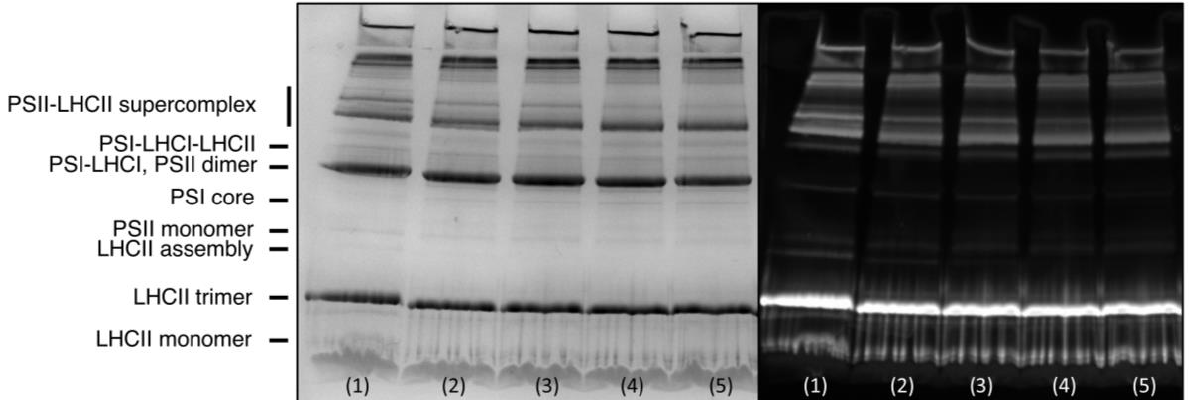
Figure 5. CN-PAGE of untreated isolated thylakoid membranes (lane 1) and membranes treated with 2 U mL − 1 PLA1 (lanes 2–5). The figure also shows the assignments of the different bands. Lanes 2–5 respectively indicate that the solubilization of samples started 0, 30, 60, and 120 min after PLA1 treatment. Left and right panels respectively indicate the gels transilluminated with visible light and Chl- a fluorescence emission (excitation wavelength, 468 nm).